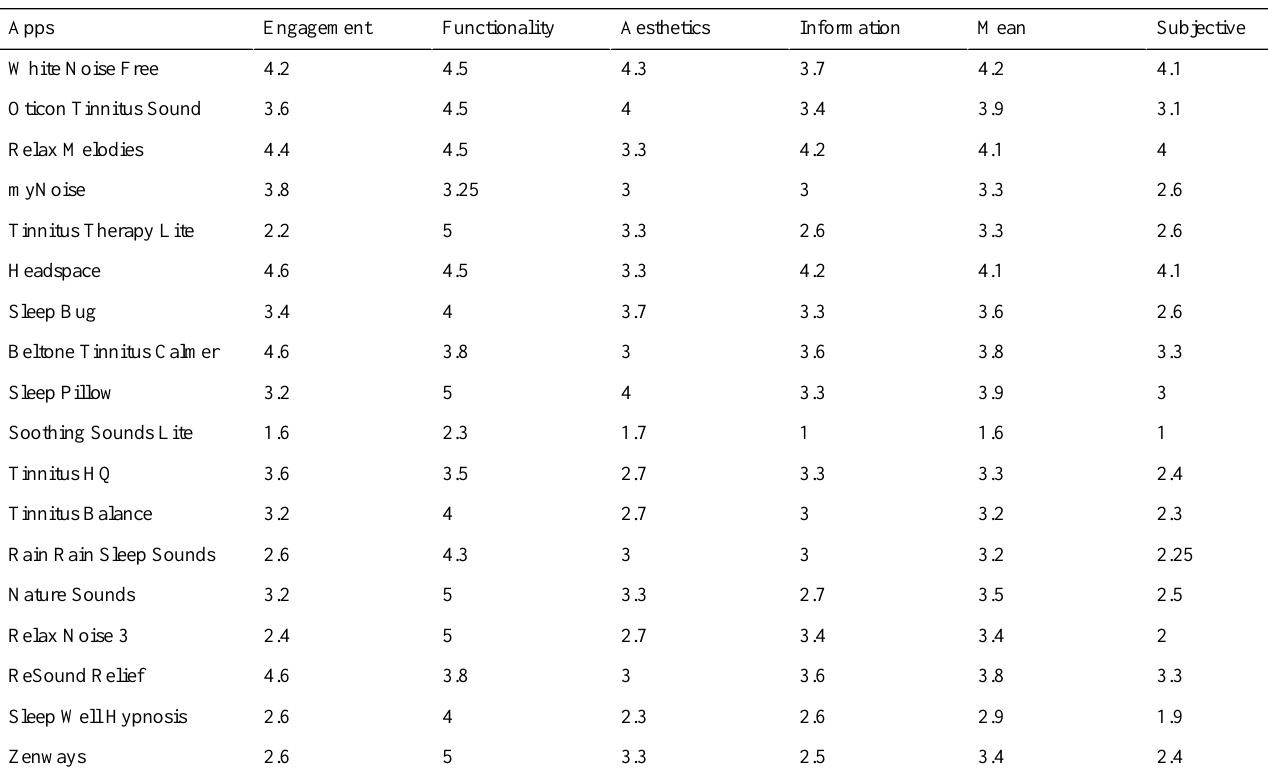
Table 2. The Mobile App Rating Scale mean scores for 18 most cited apps.